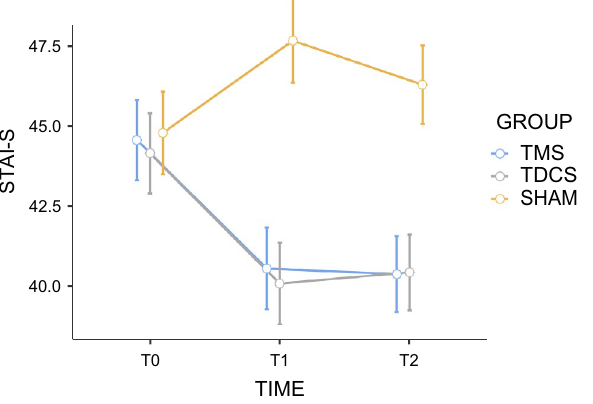
Figure 6. Effects of active repetitive transcranial magnetic stimulation (rTMS), active transcranial direct- current stimulation (tDCS), and sham stimulation on average anxiety state (STAI-S). The scores were obtained before the first stimulation session (T0), after the 5th consecutive stimulation session (T1) and 30 days after (T2). For the sake of simplicity, and as the effects of sham rTMS and sham tDCS were remarkably similar regardless of the order in which they were conducted, we present the mean values grouped into a single sham- stimulation group. Error bars indicate standard error of the mean. STAI-S State-Trait Anxiety Inventory (state subscale).